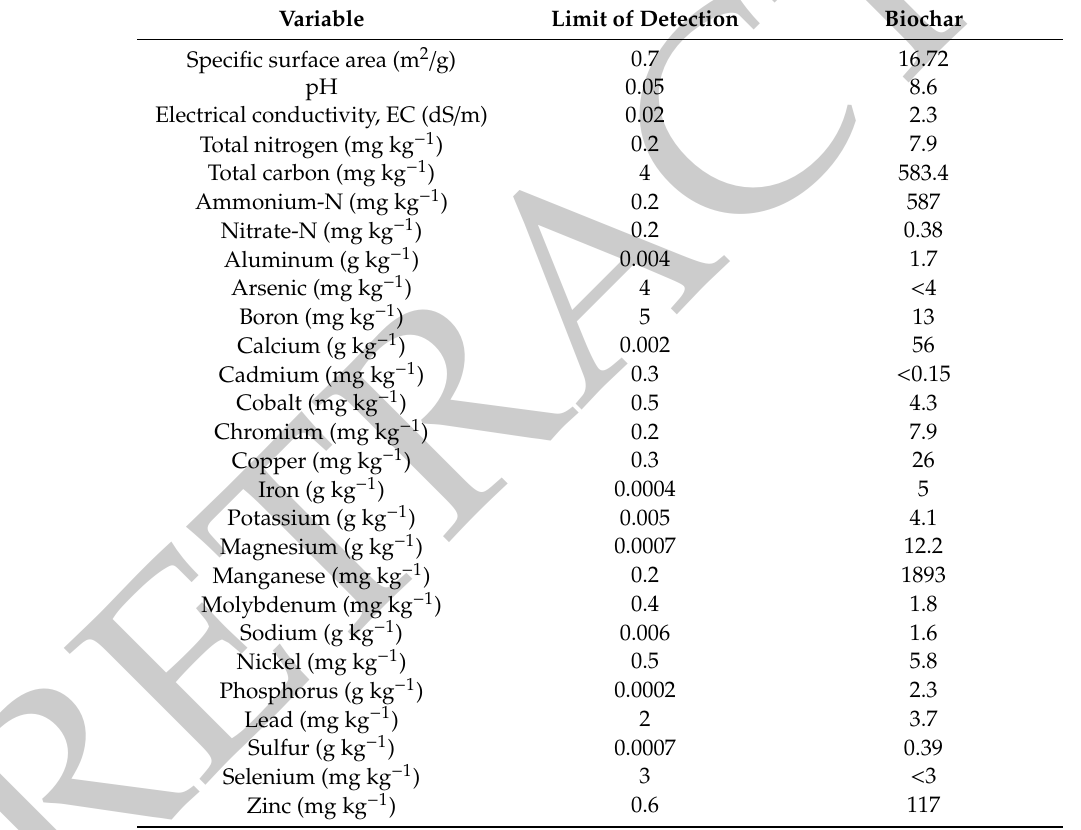
Table 2. Basic physical and chemical properties of biochar used in this